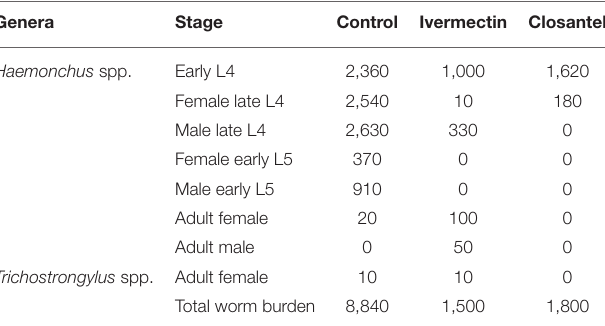
Trichostrongylus spp. Adult